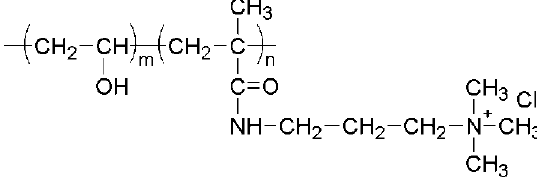
Figure 1. Chemical structure of poly(vinyl alcohol- co -methacryloyl aminopropyl trimethyl ammonium